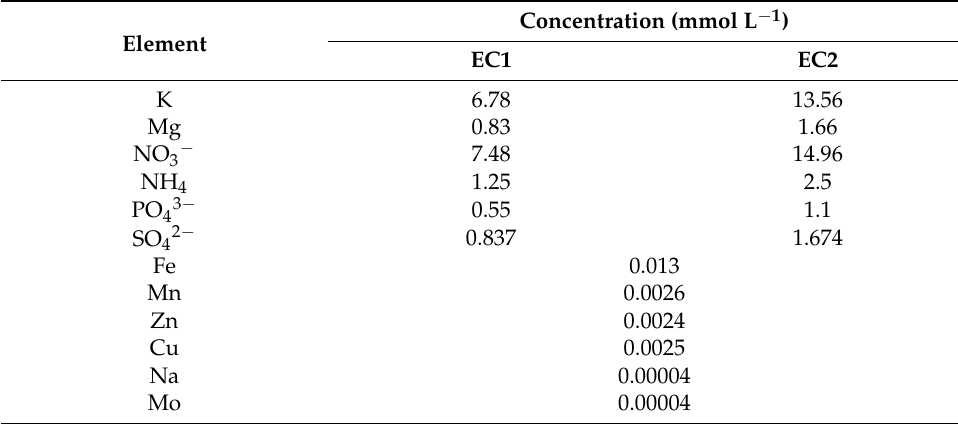
Table 1. The composition of nutrient solutions with electrical conductivity (EC) of 1 and 2 dS m − l (EC1 and EC2, respectively) was employed in the current